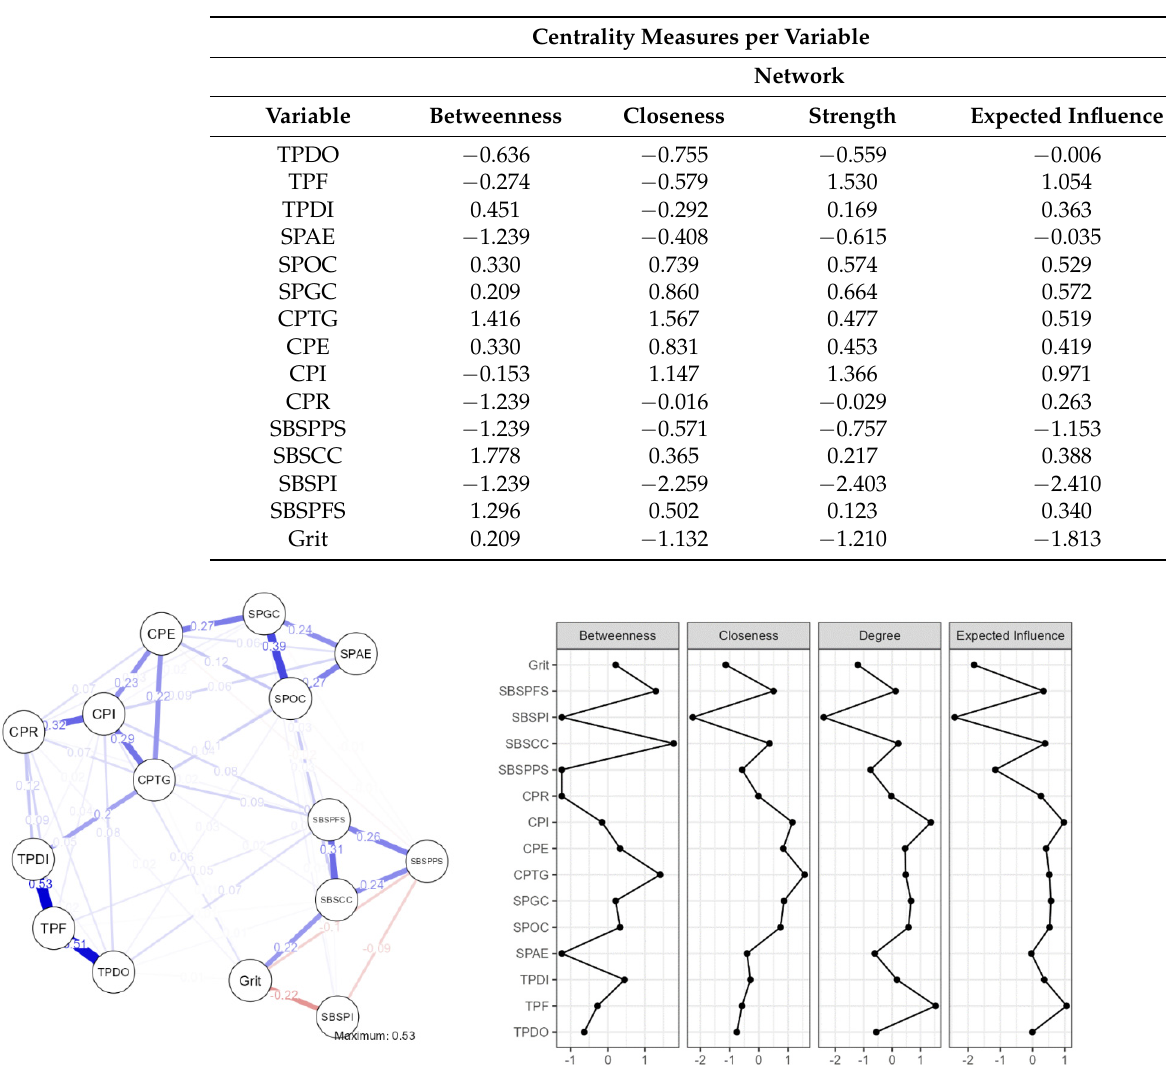
Table 3. Network analysis centrality measures.